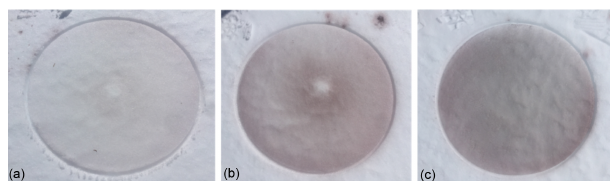
Figure 4. Images of three hematite depositions allow for visual in- spection of the deposition uniformity. Panels (a) and (b) represent a previous apparatus design which featured a fan mounted inside the deposition chamber, which created less uniform depositions. Panel (c) represents a hematite deposition using the final configuration of the